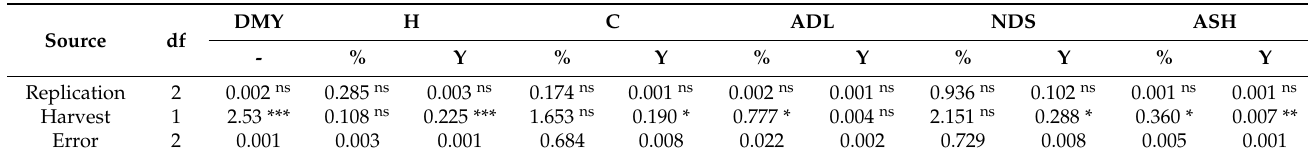
(i.e., dry biomass composition yield) were significanly affected by harvest time (except for the ADL yield). Table 1. One-way ANOVA for main effect (harvest) on biomass dry matter yield (DMY), hemicellulose content and yield (H, % and Y) cellulose content and yield (C, % and Y), lignin content and yield (ADL, % and Y), neutral detergent soluble content and yield (NDS, % and Y), ash content and yield (ASH, % and Y). Degree of freedom (df) and adjusted mean square significance: p ≤ 0.001 (***),